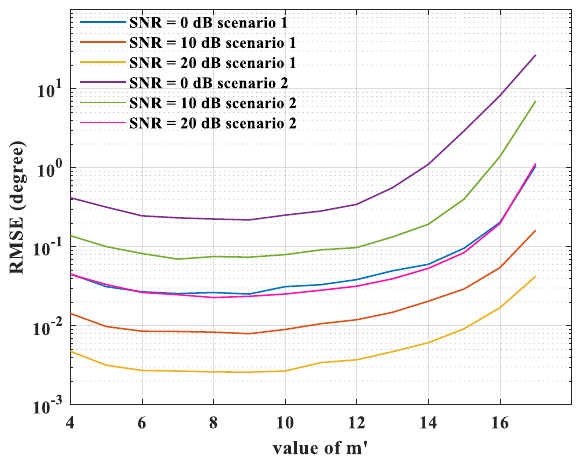
Figure 8. RMSE versus value of m .